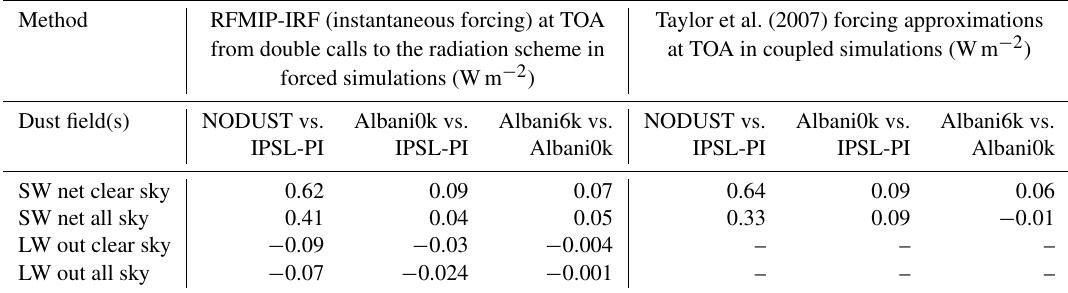
Table 3. SW net and LW outgoing dust radiative forcing (Wm − 2 ) at TOA in clear sky and all sky conditions as estimated from the different simulations. The RFMIP-IRF method diagnoses the forcing online at each model radiation time step with respect to a reference (using a double call to the radiation scheme). This has been done here in simulations without oceanic adjustment. The Taylor et al. (2007) method diagnoses the total radiative forcing of dust (forcing and feedback) from the fully coupled experiment after ocean adjustment. This method does not allow us to diagnose LW IRF. The reader is referred to Sect. 4.1 and to the Appendix for details on the radiative forcing